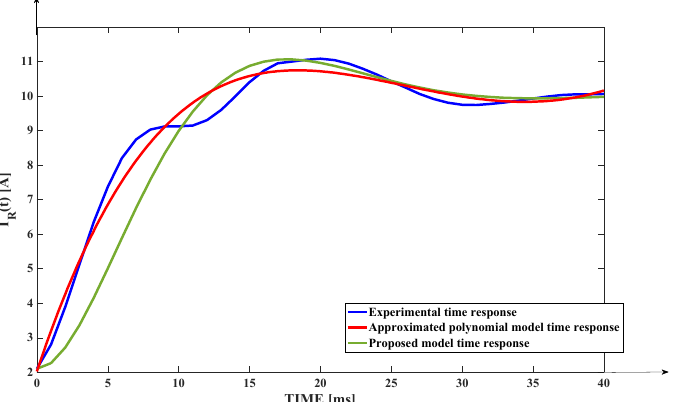
Figure 17. Comparative graph between the experimental response I R (t), the response of the approximate polynomial model and the response of the mathematical model of the second order.